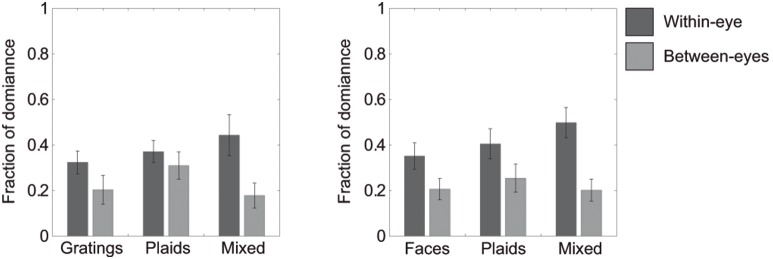
Fractions of overall dominance for Experiment 2.Within-eye dominance is presented in dark grey. Between-eye dominance is presented in light grey. Error bars represent the 95% confidence intervals. Note that the dependency on the source (i.e. the eye-of-origin) of the dominant images is similar to the epoch duration data.